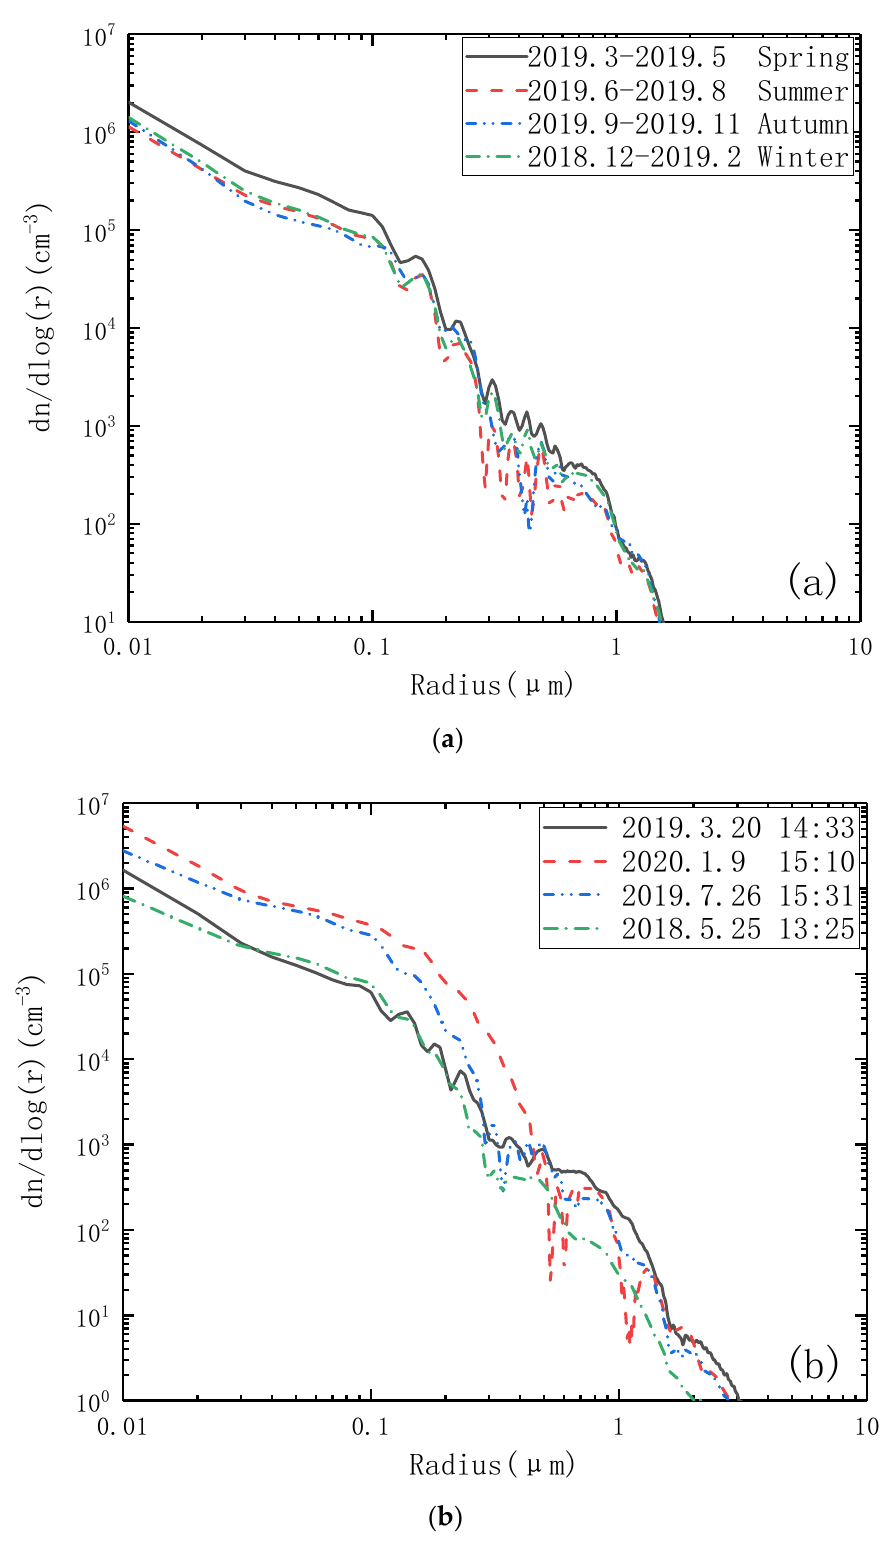
Figure 7. The aerosol PSDs inverted by the Tikhonov regularization algorithm for ( a ) four seasons, ( b ) a floating dusty day, blowing dusty day, hazy day, and sunny day.